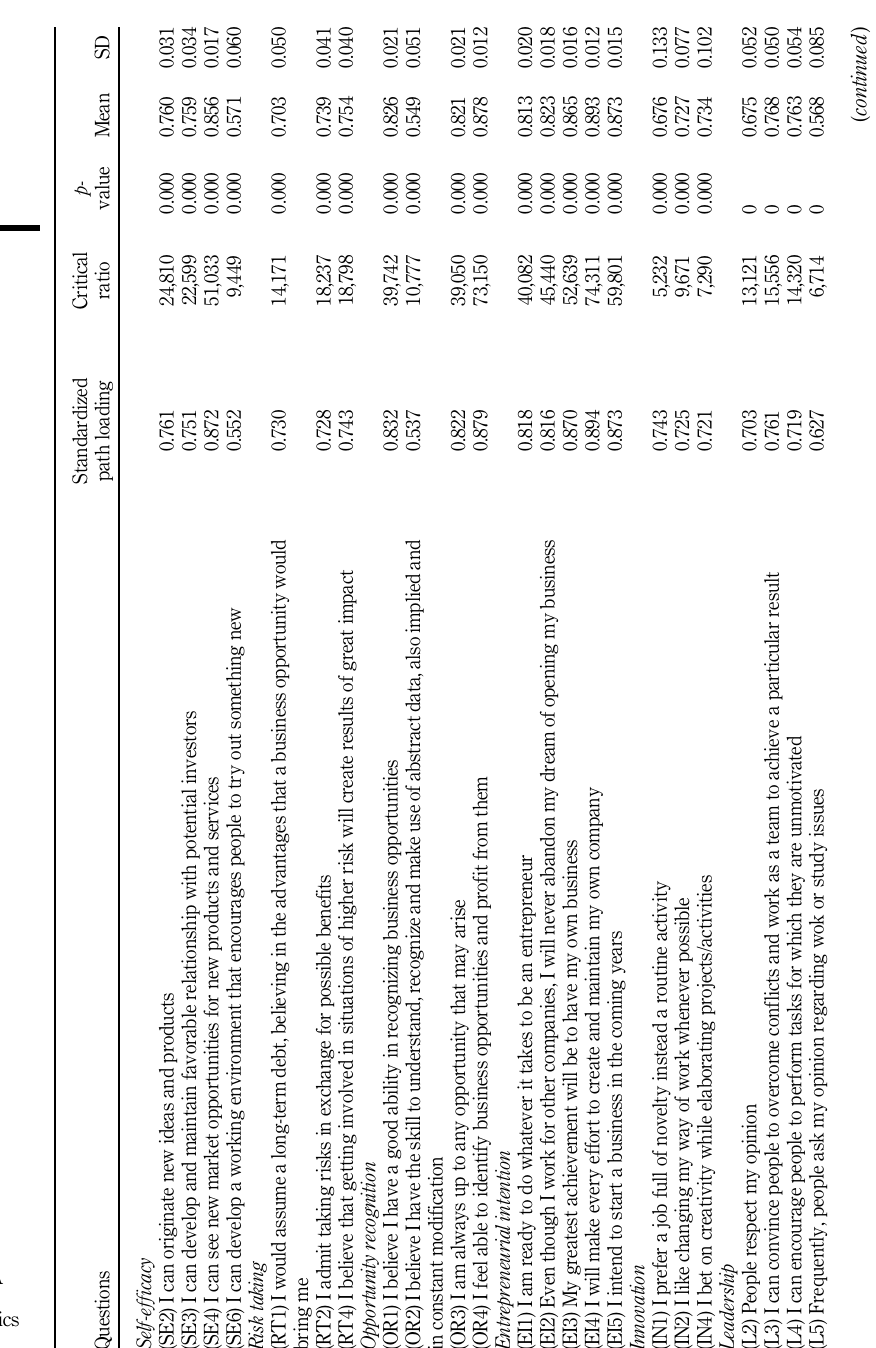
Table 1. Standardized